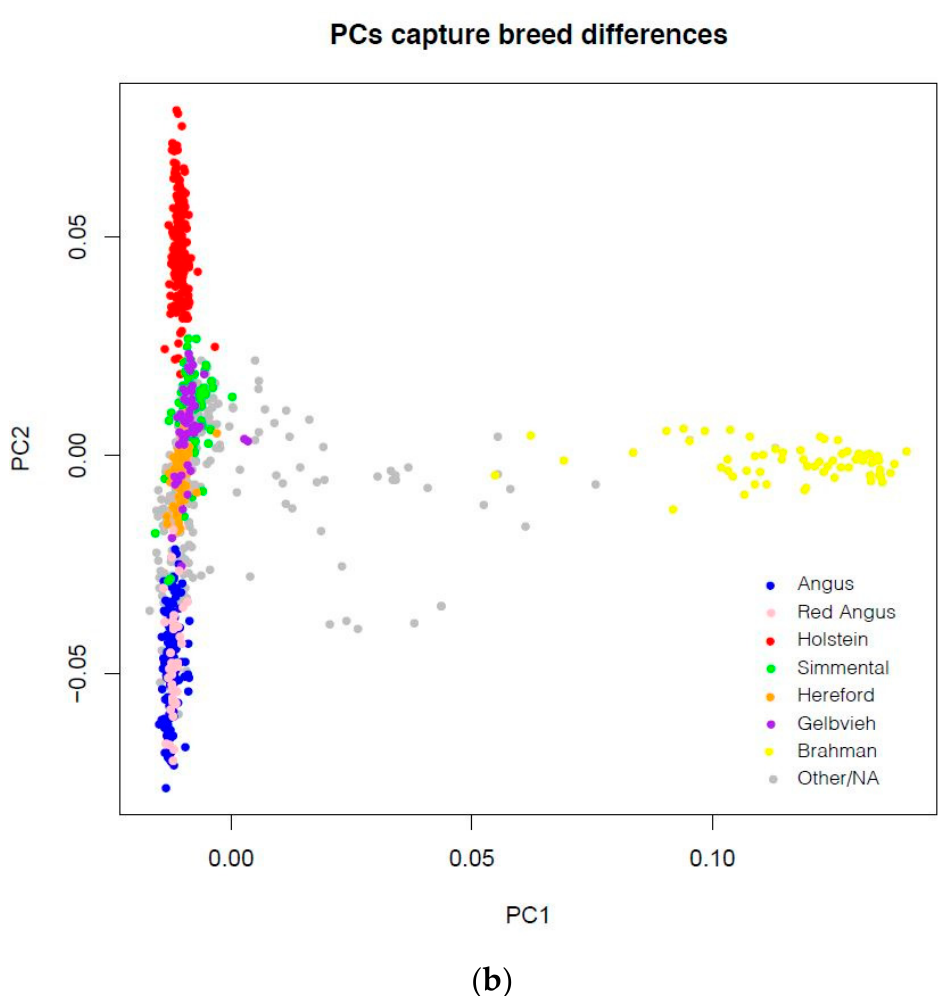
Figure 1. Principal component (PC) analysis of the haplotype reference panel. ( a ) Overlap among projects sequenced with different platforms; ( b ) depicts PC1 separating the Bos indicus from Bos taurus breeds, and PC2 separating Holstein from Angus, with other Bos taurus breeds intermediate between Holstein and Angus. The first two PC explained 11% of genomic relationships among the reference, 7% by PC1, and 4% by PC2.